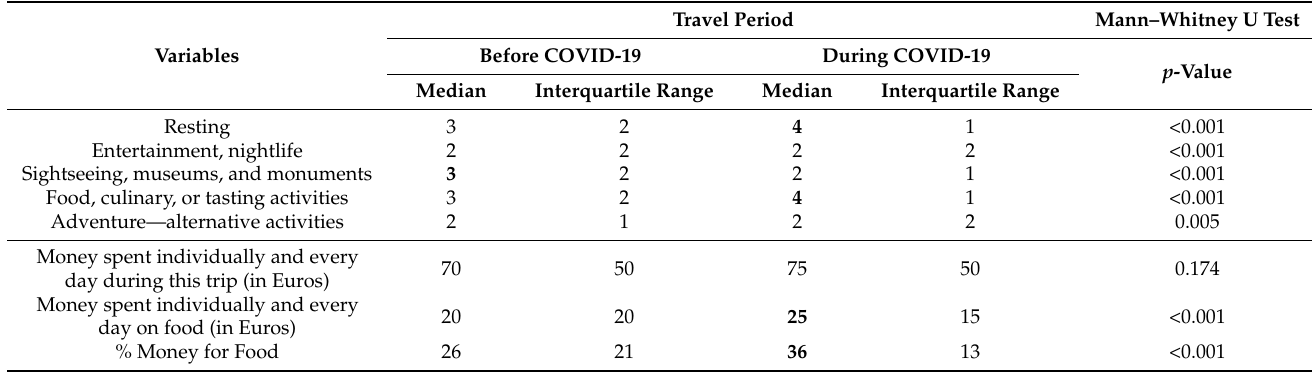
Table 3. Tourists’ activity profiles and money spent on food in each period.